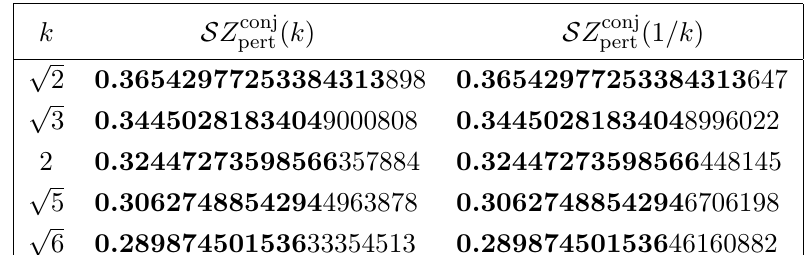
Table 1 . The S -duality restoration for the Borel-Pad(cid:19)e resummation of Z conj